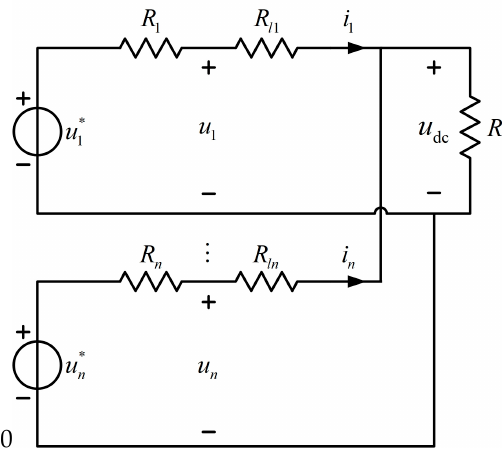
Figure 7. DC microgrid equivalent model with multiple DGs.